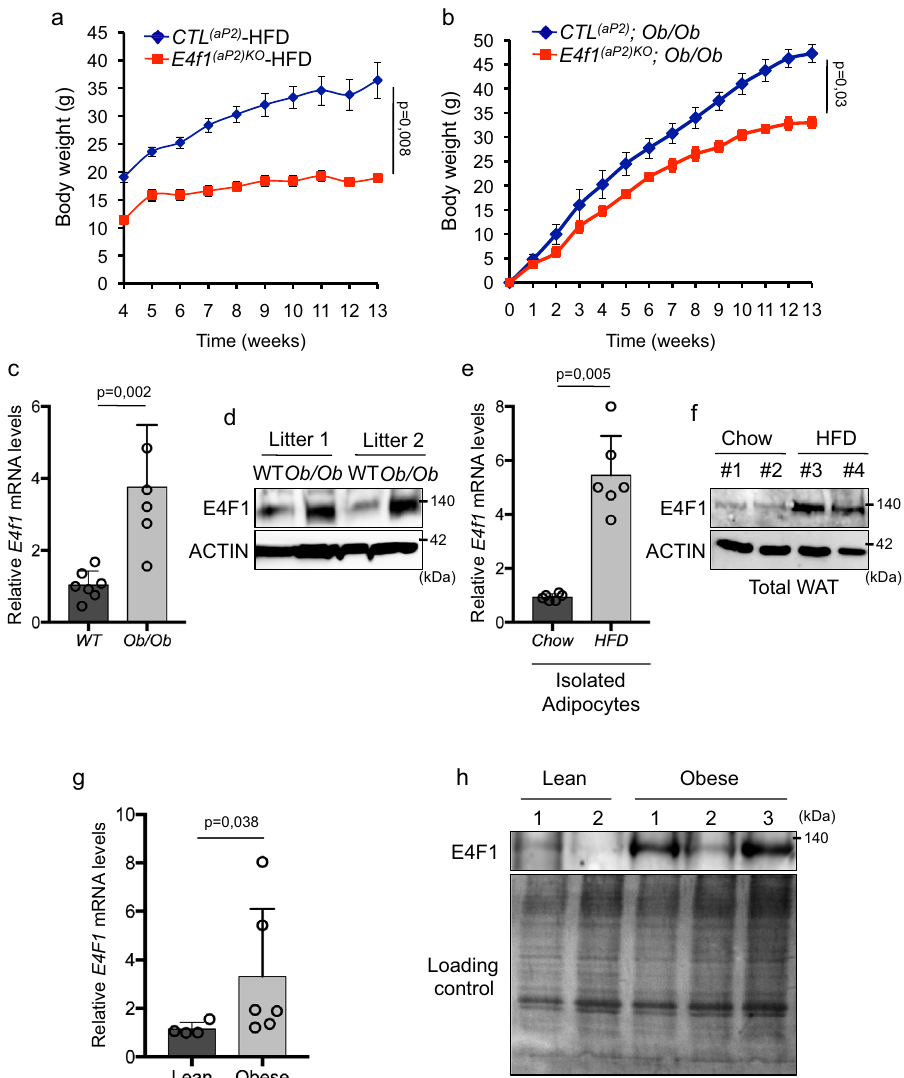
Fig. 2 E4f1 function in obesity. a Body weight of E4f1 ( aP2 ) KO mice and CTL (aP2) under high-fat diet (HFD) ( n = 5 males/group). b Body weight of E4f1 ( aP2)KO ; Ob/Ob mice and CTL (aP2) ; Ob/Ob littermates ( n = 4 males/group). c RT-qPCR analysis of E4f1 mRNA levels in epidydymal white adipose tissue (WATe)